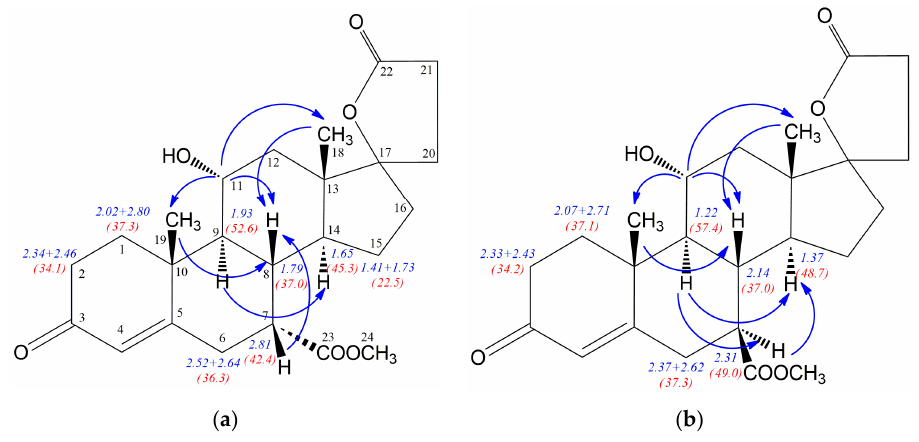
Figure 2. Crucial 1 H- and 13 C-NMR chemical shifts and NOE effects for 11-hydroxyesters: ( a ) (7 α ,11 α ,17 α )- 12 ; ( b ) (7 β ,11 α ,17 α )- 12a . Table 2. The 1 H- and 13 C-NMR spectral data in CDCl 3 for 11-hydroxyesters (7 α ,11 α ,17 α )- 12 and (7 β ,11 α ,17 α )- 12a . 1 H-NMR (1) 13 C-NMR Proton 12 12a Carbon 12 12a H-1a